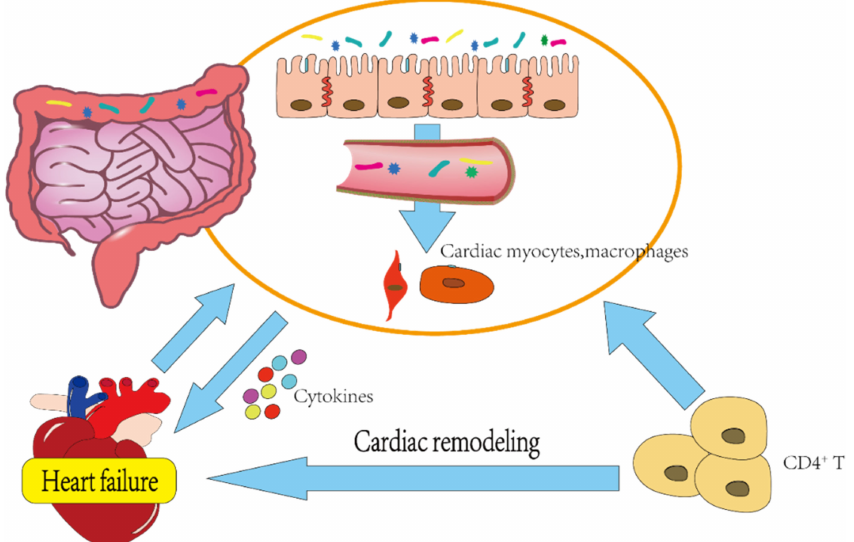
Figure 1. Correlation between gut microbiota and HF. The gut microbiota of patients with heart failure is disturbed, leading to the destruction of intestinal conjunction and the impairment of intestinal mucosal integrity. The gut microbiota entering the blood binds to the Toll-like receptor 4 (TLR4) on the surface of cardiac myocytes and macrophages, promotes the secretion of proinflammatory cytokines, and further aggravates heart failure. In addition, the gut microbiota aggravates cardiac remodeling by influencing immune cells, such as CD4 + T cells, and affects the progression of heart